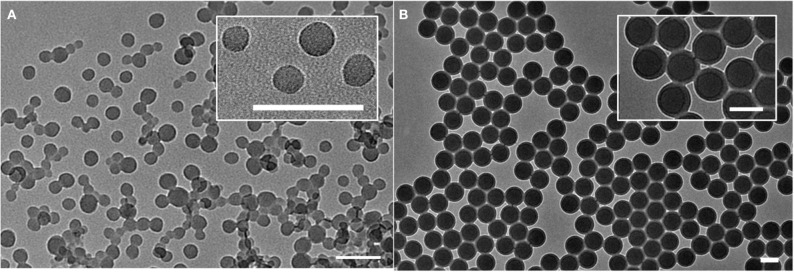
TEM images of the unloaded nanomaterials PSP (A) and PSNH2
(B). Scale bar = 100 nm.